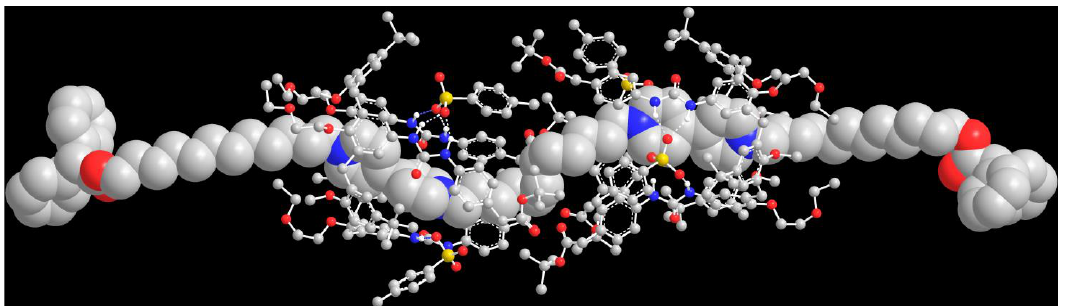
Figure 3. Perspective view of the minimised structure (PM7) of [3]rotaxane R [( TPU-ES ) 2 ⊃ 7 12 ]. All hydrogen atoms, except those involved in H-bonding with the four tosylates, have been omitted for clarity (oxygen, red; sulphur, green; nitrogen, blue; the hydrogen bonds are highlighted with dashed lines). For clarity, dumbbell 7 12 has been depicted as a space-filling structure, while the two TPU macrocycles with a ball-and-stick representation.